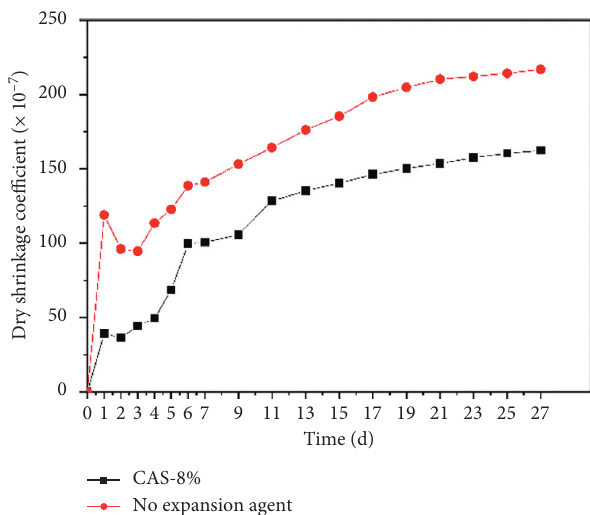
Figure 11: Comparison of dry shrinkage coefficients.